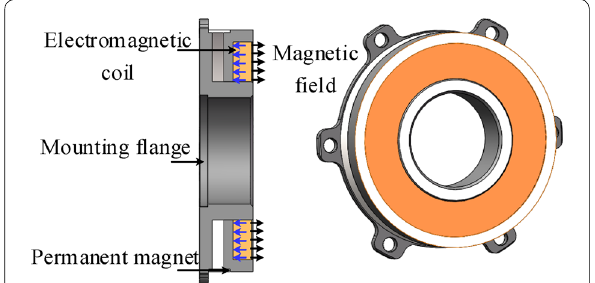
Figure 15 Structure of the electromagnetic driving source